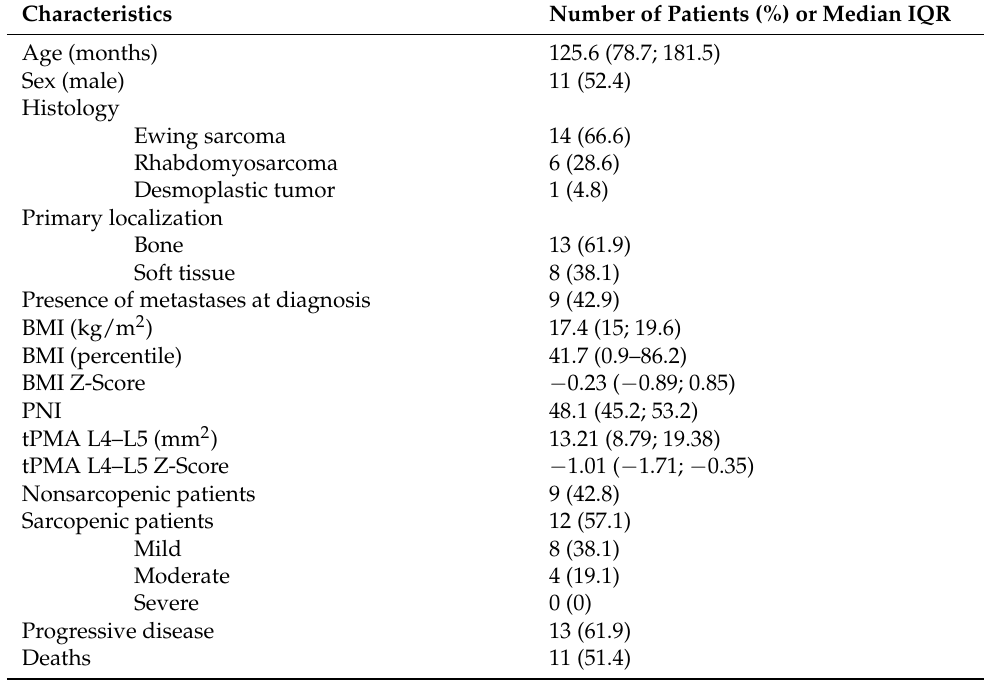
Table 1. Clinical characteristics, nutritional status, and sarcopenia at diagnosis ( n = 21).